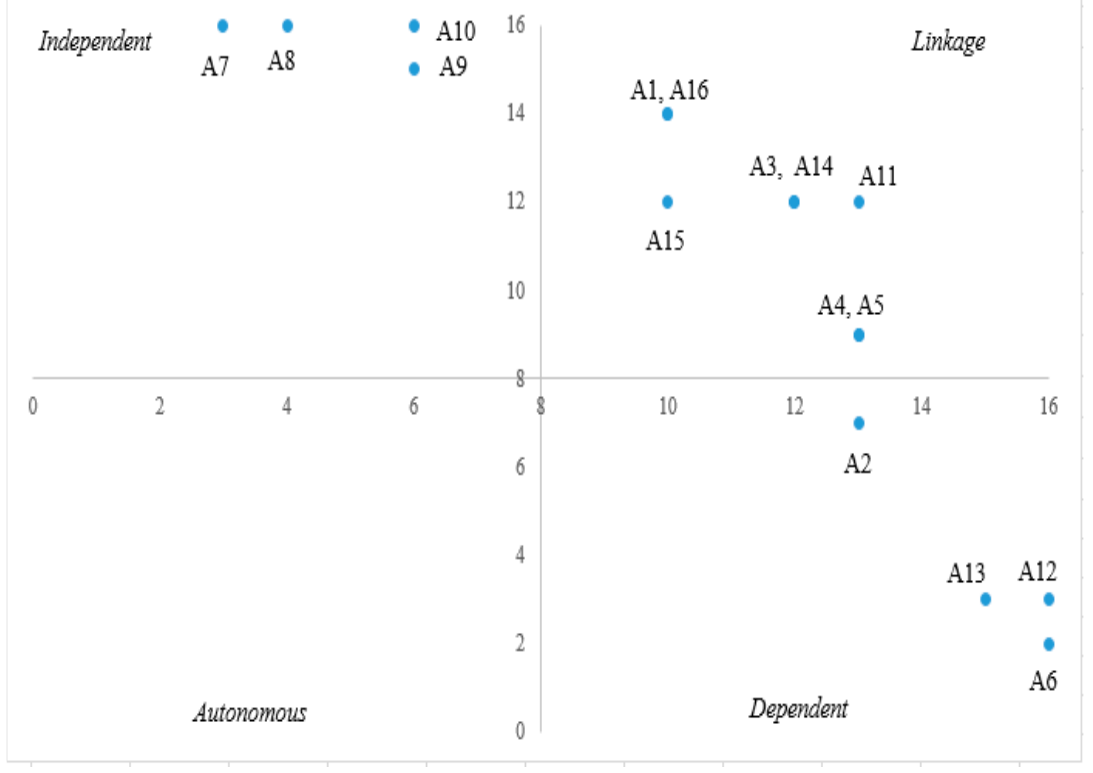
Figure 3. The MICMAC Analysis